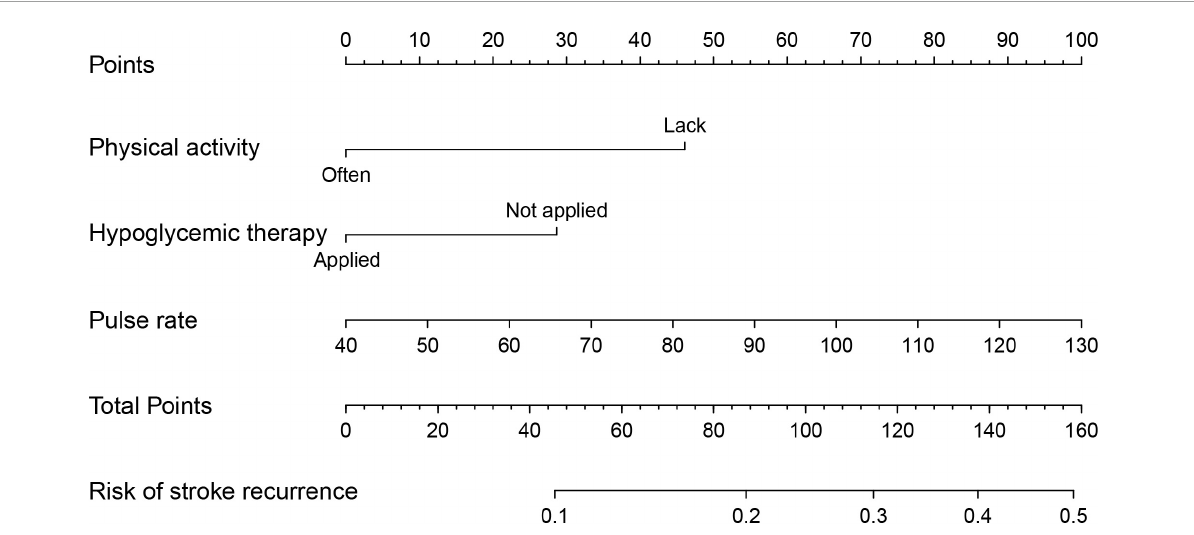
FIGURE6 Nomogram to predict 36-month risk of stroke recurrence. Draw a line perpendicular from the corresponding axis of each factor until it reaches the top line labeled “Points”. Sum up the number of points for all factors, then draw a line descending from the axis labeled “Total Points” until it intercepts each of the axes to predict 36-month risk of stroke